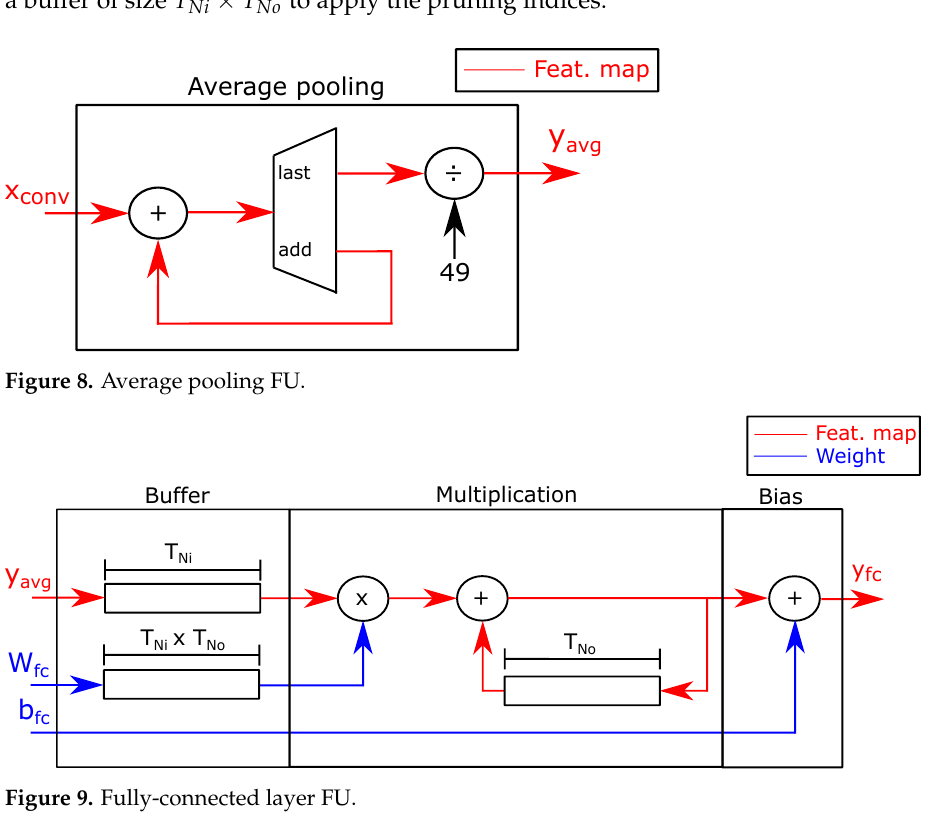
Figure 9. Fully-connected layer